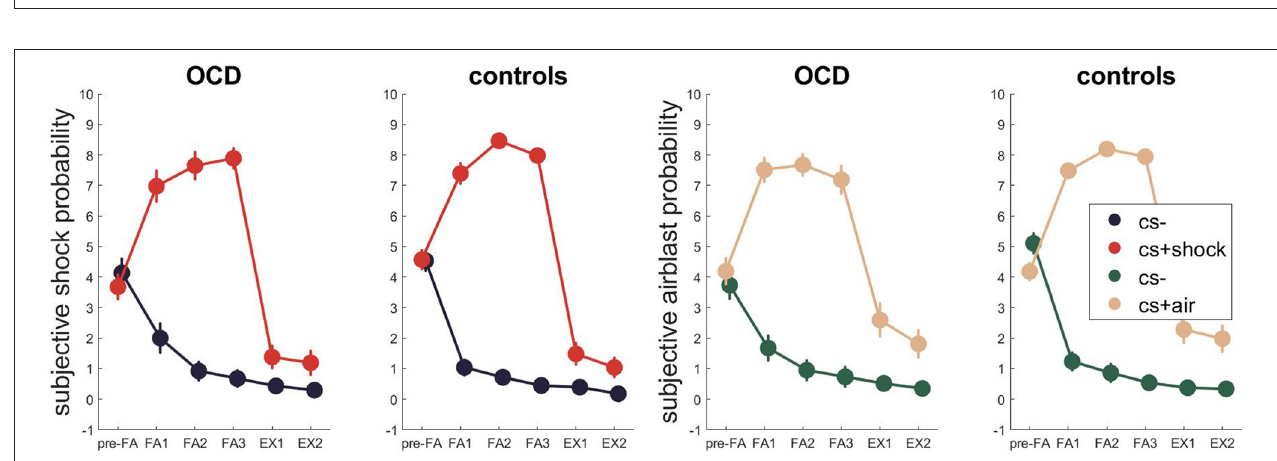
FIGURE 4 | Startle EMG across fear acquisition and extinction. Error bars are standard errors of the mean.